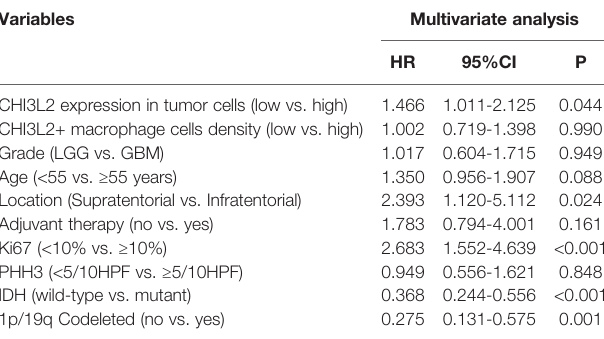
TABLE 2 | Univariate analysis of prognostic variables of overall survival. TABLE 3 | Multivariate analysis of prognostic variables of overall